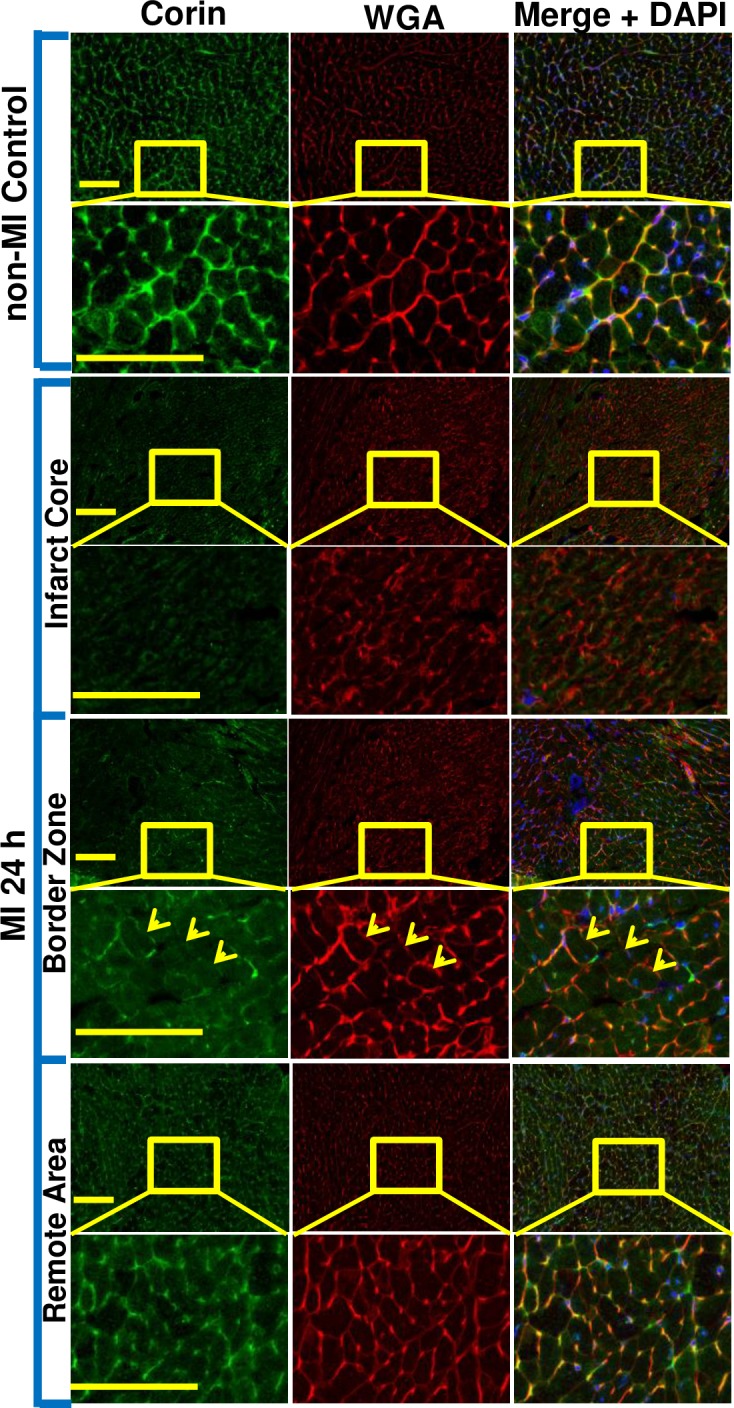
Spatial character of corin reduction in different regions of injured myocardium 24 hours post-MI.Corin protein expression in non-MI and MI hearts assessed by double immunofluorescence (IF) staining on heart coronary sections with corin antibody followed by labelling with anti-rabbit AlexaFluor® 488 (green), WGA-Rhodomine (red) and counterstaining with DAPI (blue). Representative image of normal left ventricle myocardium from non-MI hearts (row 1 & 2 panels), infarct core region (row 3 & 4 panels) and border zone (row 5 & 6 panels) as well as remote area (row 7 & 8 panels) in MI hearts at low and high magnification (top vs. bottom panels, bar = 100 μm). When compared to non-MI heart, corin expression in infarct core and border zone was significantly decreased, while corin expression was relatively preserved in remote area. In addition, the integrity of cell membrane in infarct core was completely lost suggesting necrotic death. Border zone was the transition area in which the cardiomyocytes with or without cell membrane integrity co-existed. Yellow arrows indicate three individual myocytes which show reduced corin expression (green channel) though the integrity of the cell membrane were well preserved (red channel). n = 4 mice per group.